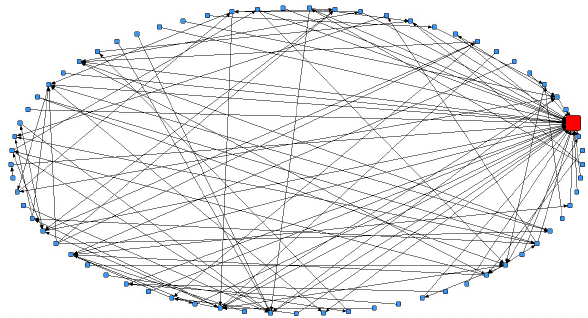
Figure 5. Complex network for one facilitator